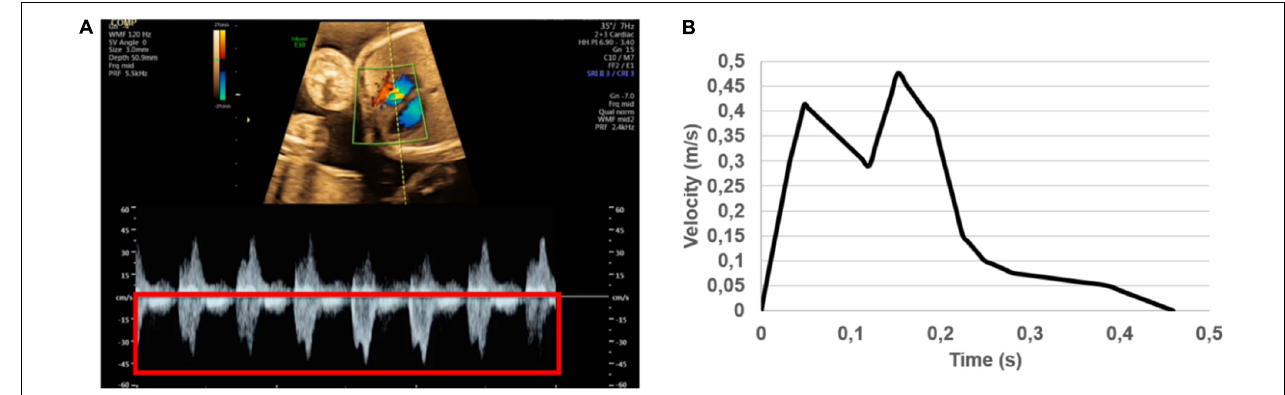
FIGURE 4 | (A) Doppler ultrasound measurements to determine the blood flow velocity waveform in the mitral valve. The red rectangle shows multiple cardiac cycles. The average of multiple cardiac cycles is used to define the inlet flow conditions. (B) Numerically plotted blood velocity waveform at the mitral valve during one cardiac cycle for the case studied in (A) . For each of the control heart, clinically measured specific inlet waveform is used to prescribe the inlet flow velocity of the CFD simulations.